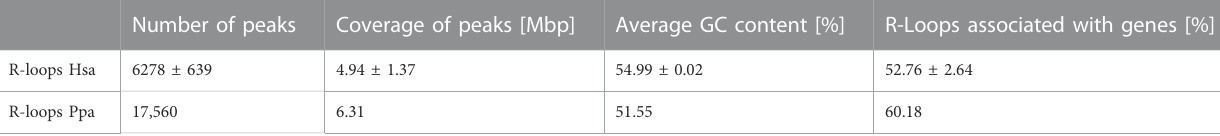
mature sperm head, suggesting their presence in non-transcribed regions or non-polyadenylated RNA as well. The applied RNAseq protocols are based on an enrichment of poly-A RNA, but the exact comparison of sperm head transcriptome data in a meaningful quanti fi able approach to estimate the relative proportion of sequenced polyadenylated transcripts versus non-polyadenylated RNA is pending.